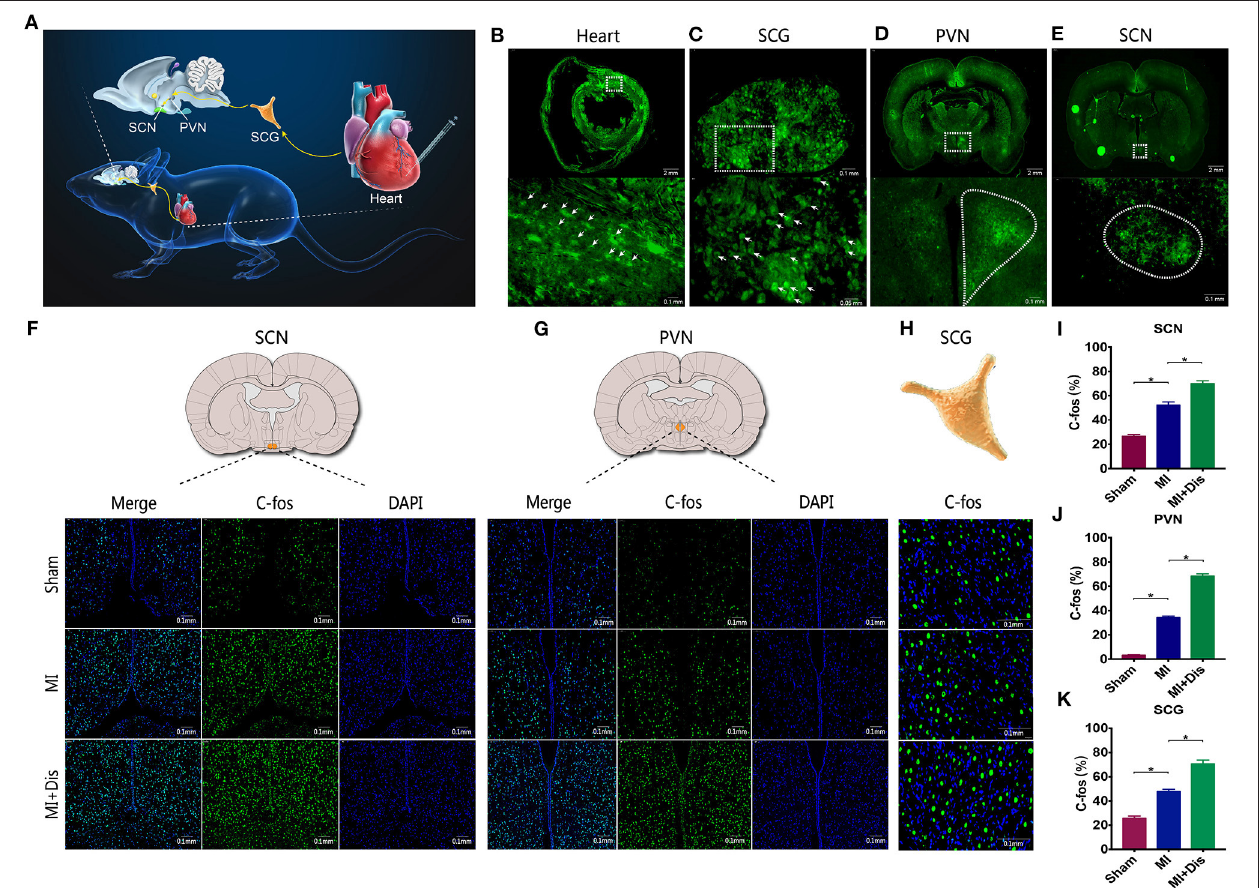
FIGURE 3 | Circadian disruption activated the “SCN-PVN-SCG-Heart” sympathetic axis. Retrograde tracer virus is injected into the ventricular myocardium in the apex region (A) , and labeled neurons were identified in the heart (B) , SCG (C) , PVN (D) , and SCN (E) regions. (F–K) Expression levels of c-fos at the SCN, PVN, and SCG sites. EGFP, enhanced green fluorescent protein; SCN, suprachiasmatic nucleus; PVN, paraventricular nucleus of hypothalamus; SCG, superior cervical ganglion; p * <